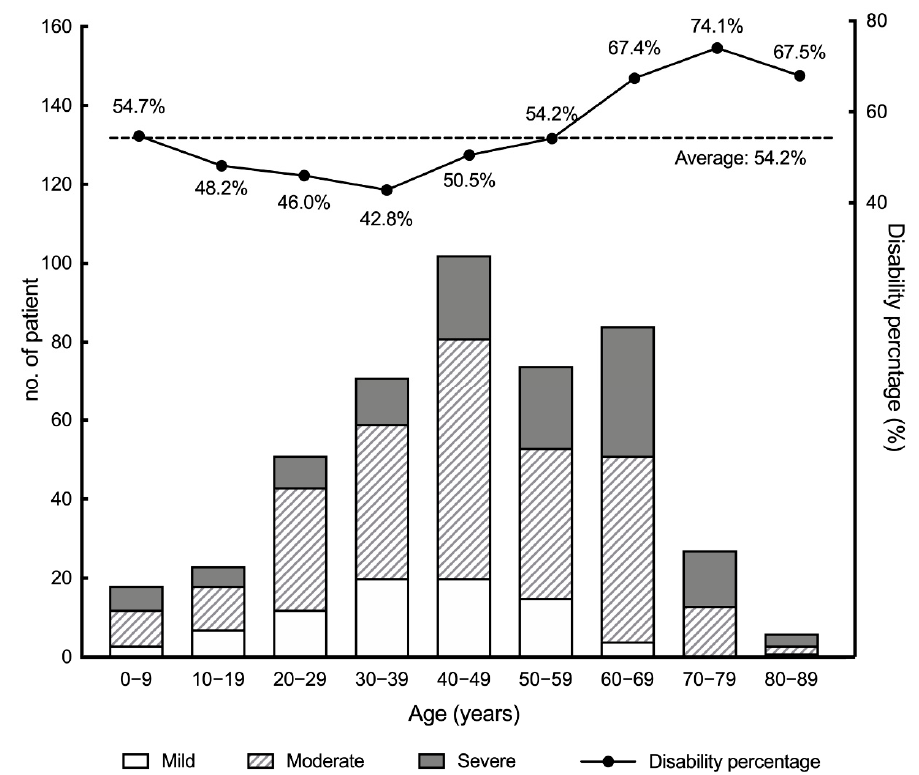
Figure 6. Disability-level distribution and disability percentage of patients with inherited retinal degenerations.